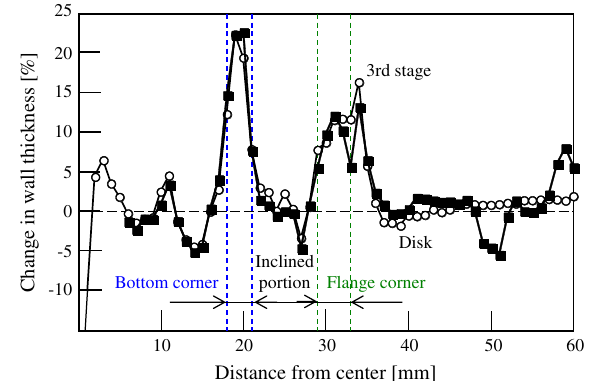
Figure 18. Distribution of change in wall thickness of formed disk.